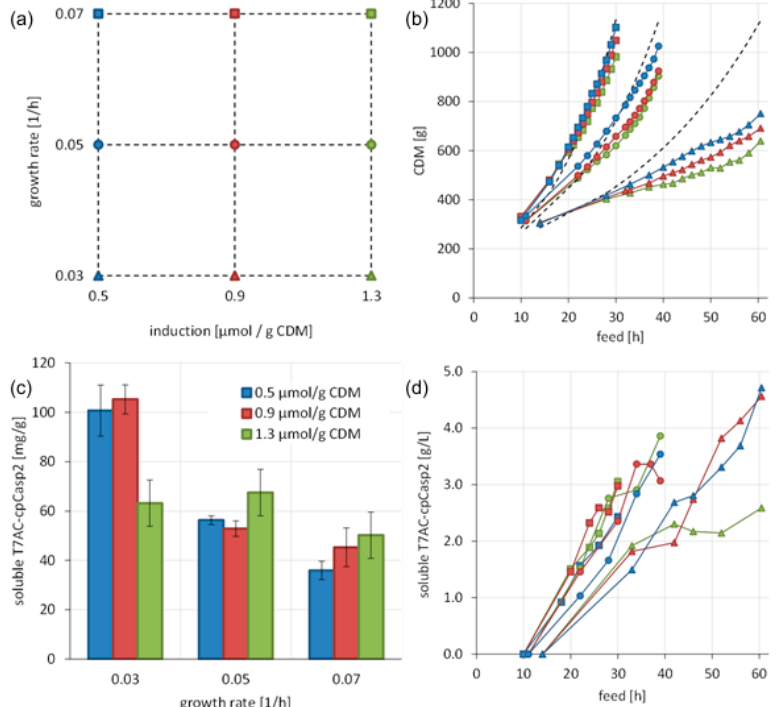
Figure 4. DoE approach to improve soluble T7AC-cpCasp2 expression: nine cultivations of E. coli BL21(DE3)(pET30a-T7AC-cpCasp2) during carbon limited 2 phase fed-batch cultivation, (growth rate μ = 0.17, followed by different growth rates during induction, μ = 0.03, 0.05 and 0.07 h − 1 ) with three different IPTG induction strengths (0.5, 0.9 and 1.3 μ mol IPTG/g CDM). ( a ) Overview of parameters that were varied with legend to colors and symbols used in the other panels. The colors correspond to the induction strength and the symbols correspond to the growth rate. ( b ) Cell growth at different conditions. ( c ) Specific titer at the end of the cultivation; mean values and experimental standard deviation are shown ( n = 3). ( d ) Soluble expression in the course of time as volumetric titer [g/L].